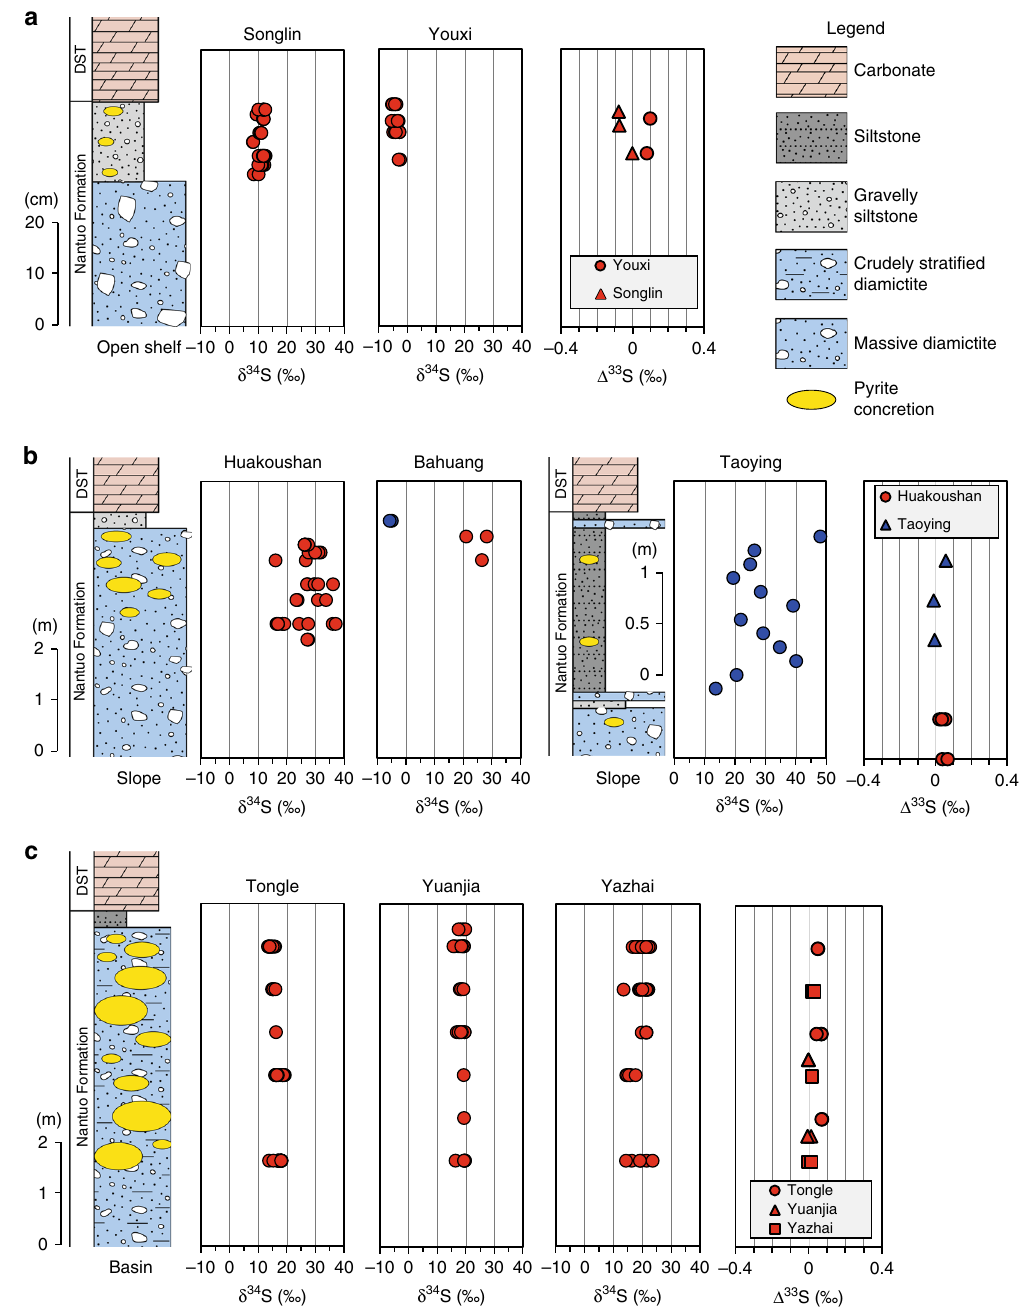
Fig. 2 Sulfur isotopic compositions of pyrite concretions (red symbols) and disseminated pyrite (blue symbols) in the Nantuo Formation. a Limited variations of δ 34 S py and variable Δ 33 S values of pyrite concretions from open shelf environment. b Variable δ 34 S py and slightly positive Δ 33 S values of pyrite concretions and disseminated pyrite from slope environment. c Limited variations of δ 34 S py and variable Δ 33 S values of pyrite concretions from